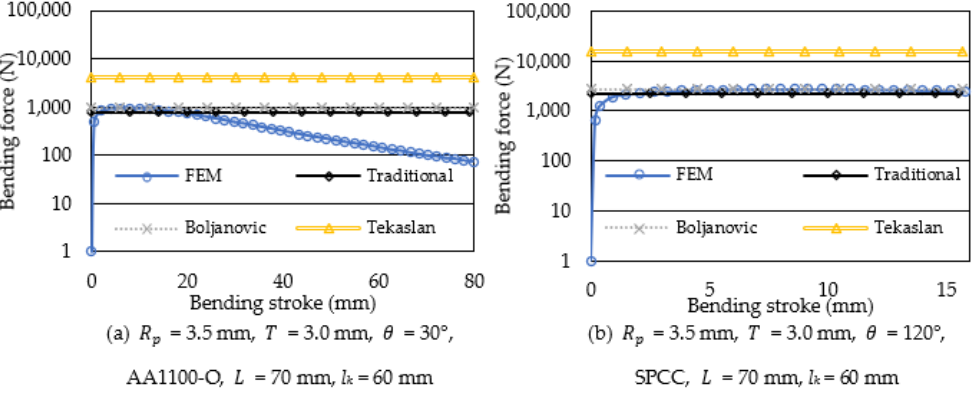
Figure 7. Comparison of bending forces obtained using the traditional, Boljanovic, and Tekaslan formulas, and FEM simulation results in the case of V-air bending with respect to various bending conditions.